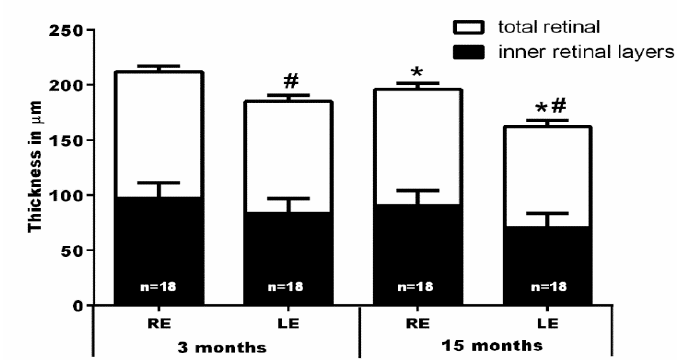
Figure 6. Graph bars showing the reduction of the mean ± SD thickness ( µ m) of the total (from inner side of the nerve fiber layer to outer segment layer) and inner (from the inner side of the nerve fiber layer to outer margin of inner nuclear layer) retina after NMDA intravireal injection into the left eye, measured in the volume scan analyses shown in Figure 5. Note: * Significant di ff erences compared to the same eyes analyzed at 3 months (Kruskal-Wallis test, p < 0.001); # significant di ff erences when compared to their contralateral eyes at the same time interval (Mann-Whitney Test, p < 0.001); RE = right fellow eye; LE = left eye (NMDA-injected).